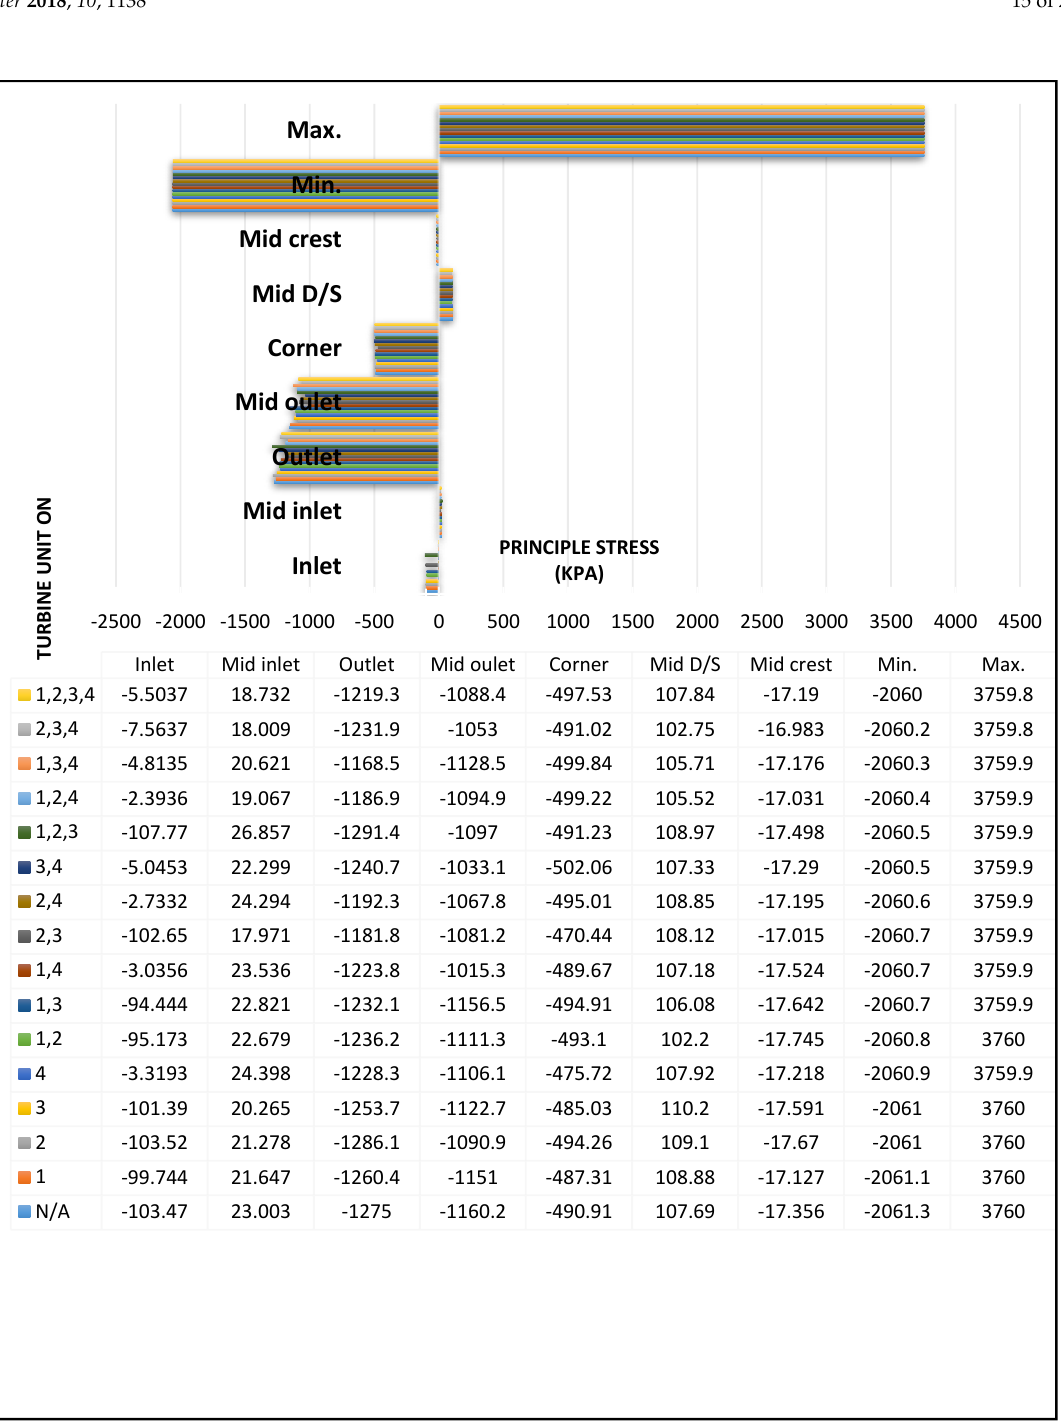
Figure 14. The principle stress values in the selected points of the Temenggor dam body according to running turbine units at the minimum water level.